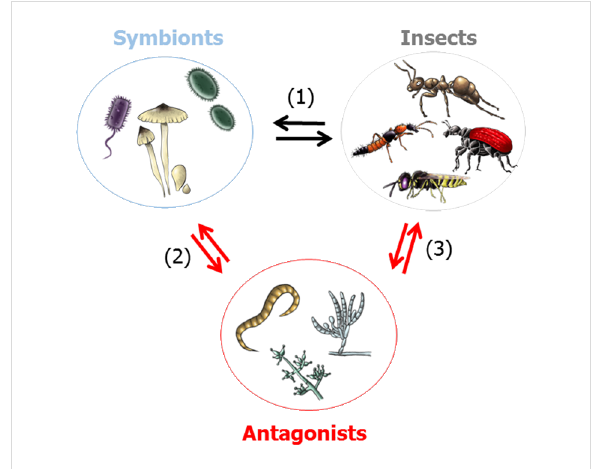
Figure 2: Multilateral microbe–insect interactions. (1) Insect–symbiont interactions with both partners benefiting from the interactions. (2) Antagonistic microbial interactions (e.g., competition for nutrients and space). (3) Antagonistic microbe–insect interactions (e.g., ento- mopathogenic